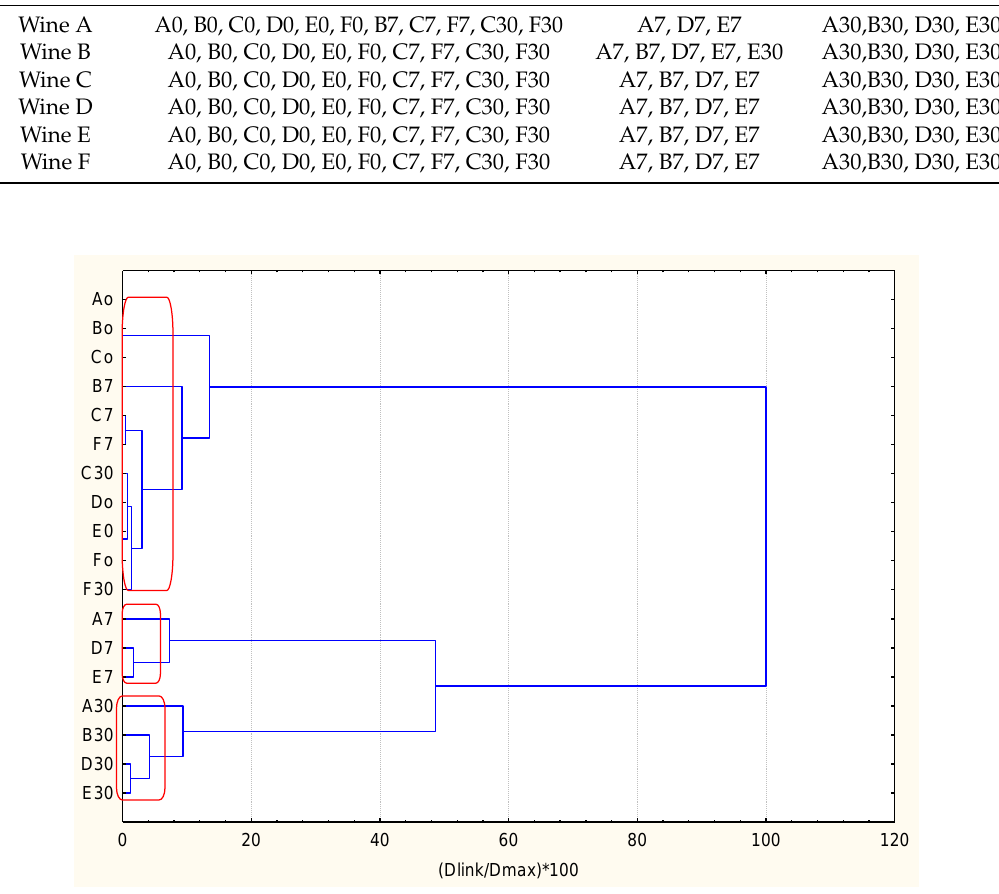
Figure 3. Hierarchical dendrogram for a wine sample (Wine A).